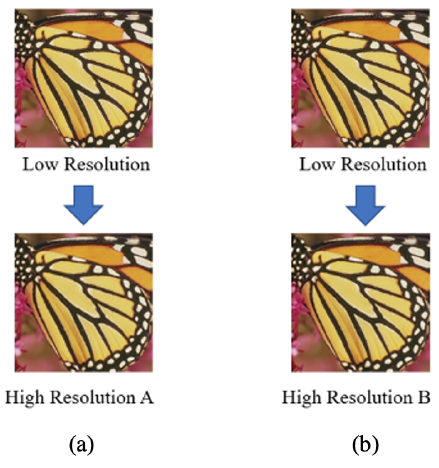
Figure 1. Restored Images: ( a ) High-Resolution A restored from the same low-resolution image used to make High-Resolution B; ( b ) High-Resolution B restored from the same low-resolution image used to make High-Resolution A. Both A and B were restored from the same low-resolution image; however, High-Resolution A and B are not the exactly same